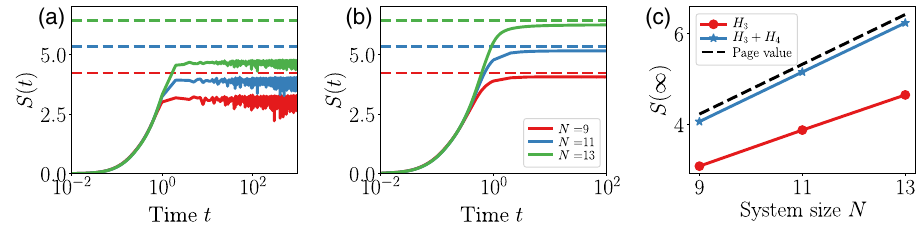
FIG. 17. Half chain entanglement entropy (EE) growth for an initial random product state for different system sizes. The dashed line signals the Page value [104]. (a) shows the behavior of the EE for the minimal model H 3 . The entanglement reaches a size-dependent saturation value below the Page value. This result can be understood from the exponential fragmentation of the Hilbert space. However, when the combined Hamiltonian H 3 þ H 4 is considered in (b), the EE almost reaches the Page value. We associate the offset between them to the existence of still exponentially many invariant subspaces. (c) Scaling of the time-averaged saturation value for EE reached at long times. While for H 3 the slope is different from that of the Page value, signaling a subthermal entropy density in the steady state, the offset for the combined Hamiltonian appears to be